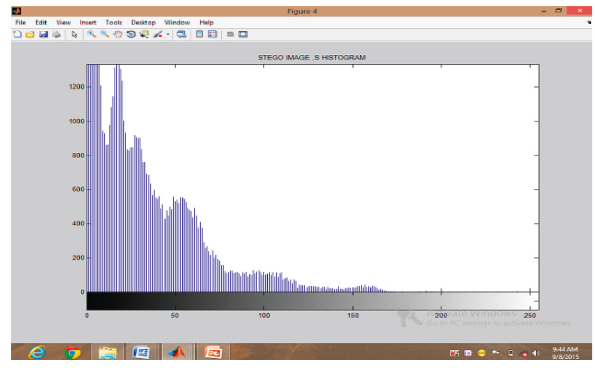
Figure 6: Histogram of stego image of